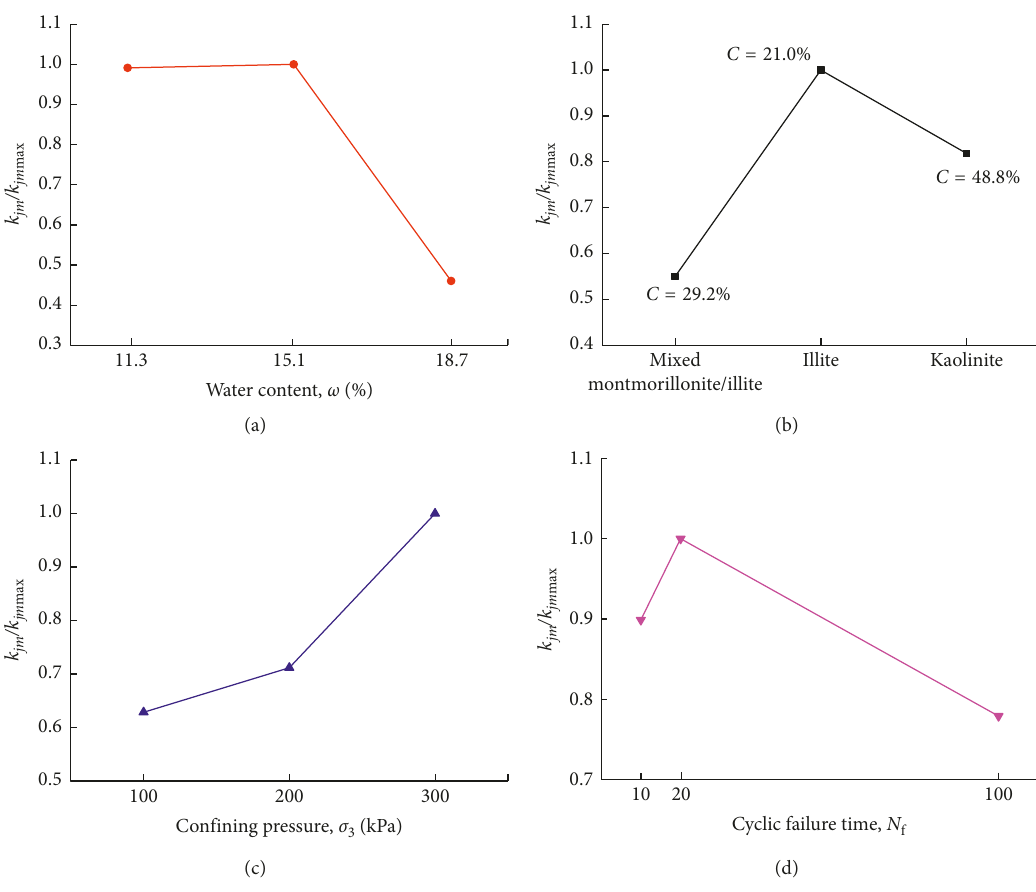
Figure 10: Factor effects on τ df . k jm / k jm max versus (a) ω , (b) M , (c) σ 3 , and (d) N f . Table 4: Values of C d and φ d determined for the case of N f (cid:31) 20. Group number C d